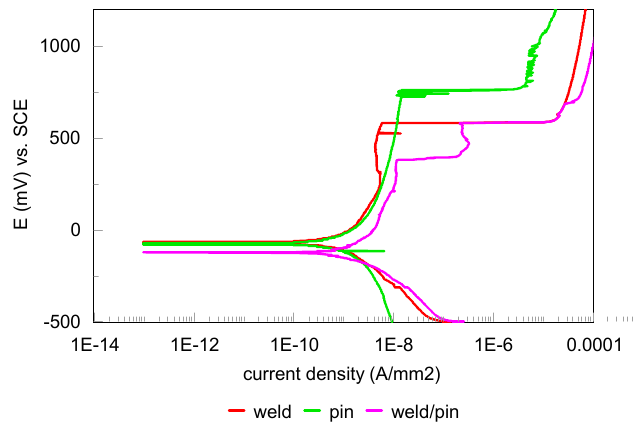
Figure 16. Average potentiodynamic polarization curves of the longitudinal surface weld, pin and the weld/pin interface. Sample #3.